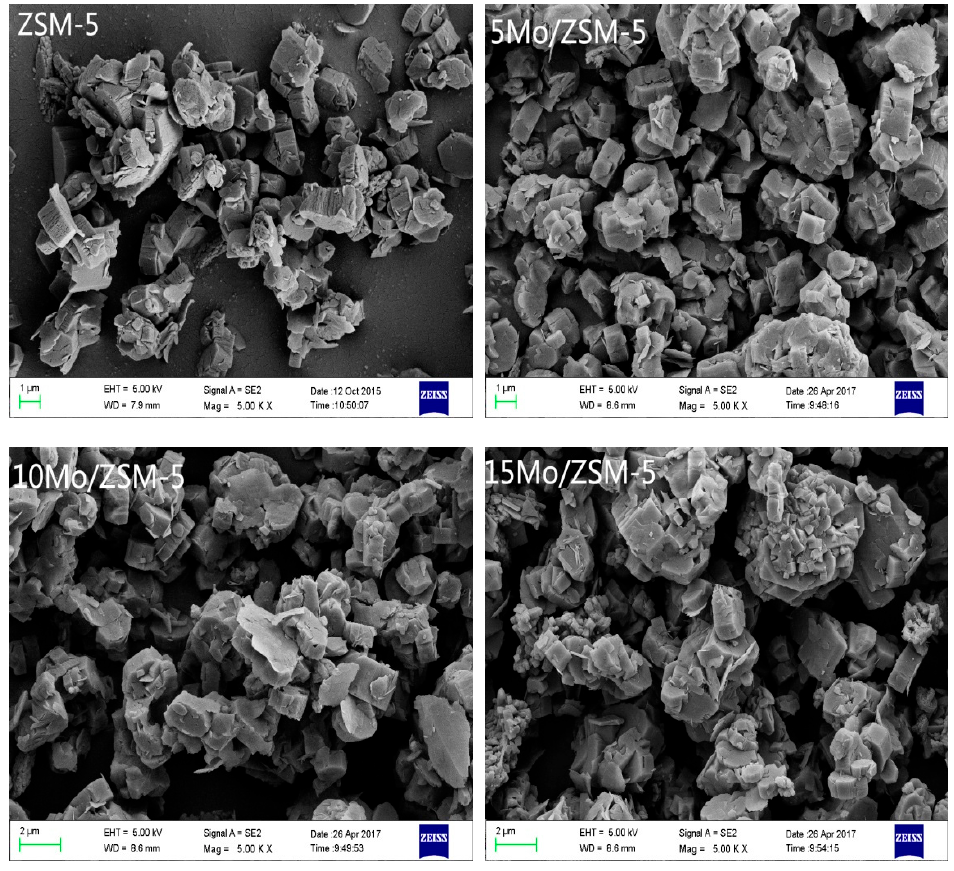
Figure 2. The scanning electron microscopy (SEM) images of the ZSM-5 and Mo/ZSM-5